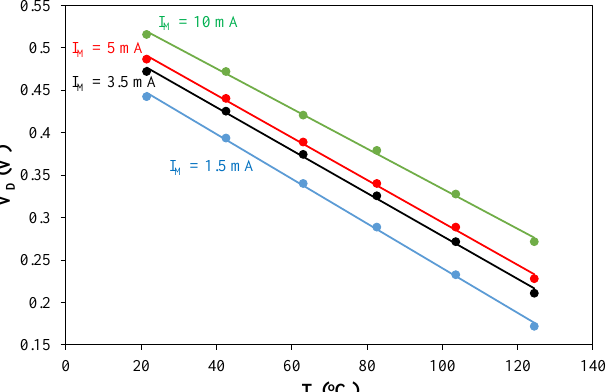
Figure 6. Thermometric characteristics of the anti-parallel diode for selected values of I M current.